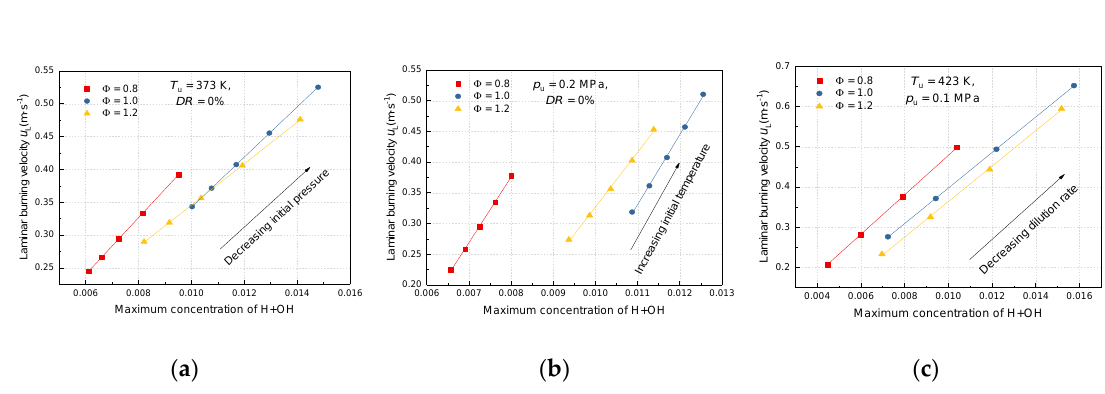
Figure 12. Laminar burning velocity versus maximum concentration of H + OH. ( a ) Under different initial pressures; ( b ) Under different initial temperatures; ( c ) Under different dilution rates. Table 4. Coefficients of the linear fit to the data of laminar burning velocity versus maximum concentration of H + OH under different initial pressures.